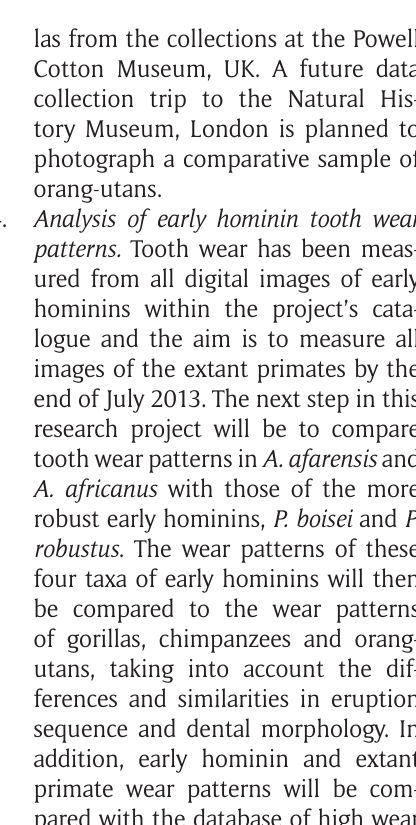
Fig. 5: Data collection at the Ditsong Museum of Natural History, South